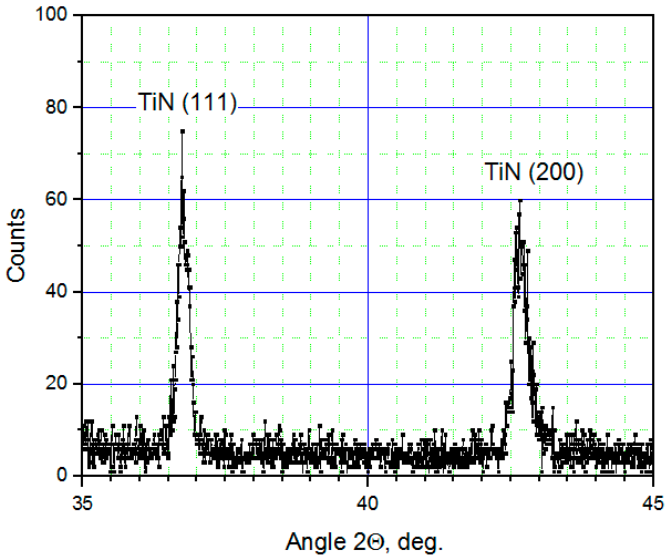
Figure 3. XRD scan recorded from a 400-nm-thick TiN film deposited on an oxide-free Si substrate.